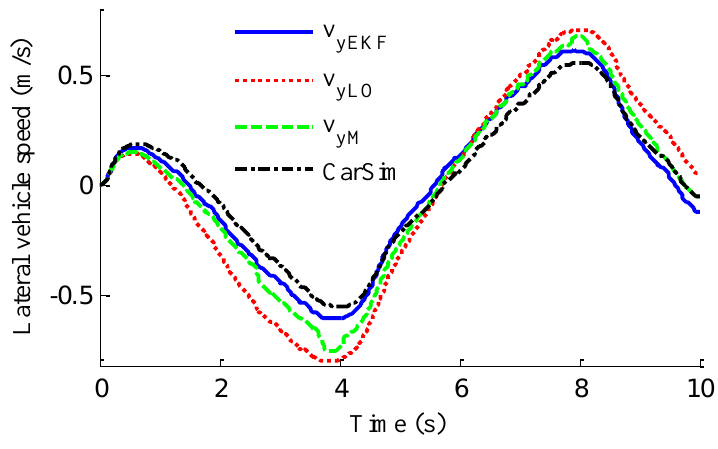
Figure 9. Estimation of lateral vehicle speed.